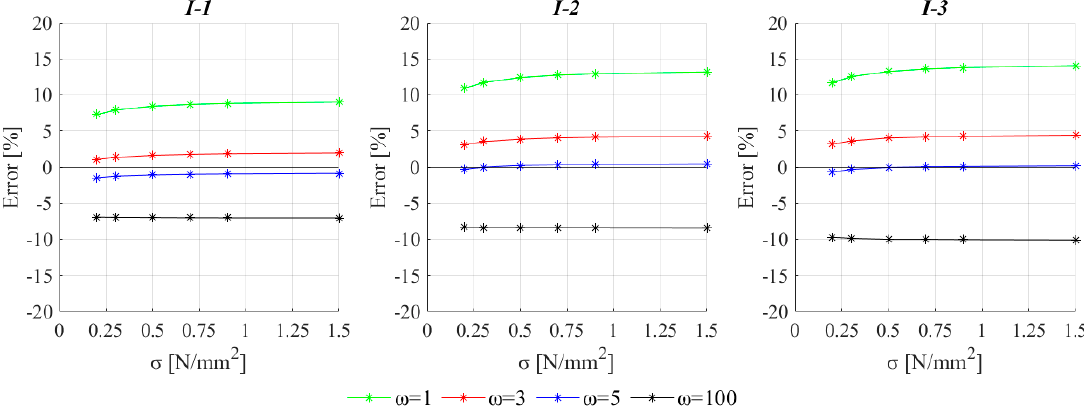
Figure 18. Percentage error on the estimate of the axial load after the application of vertical loads ( d top = 0) for the examined T-shaped 3D assemblies.